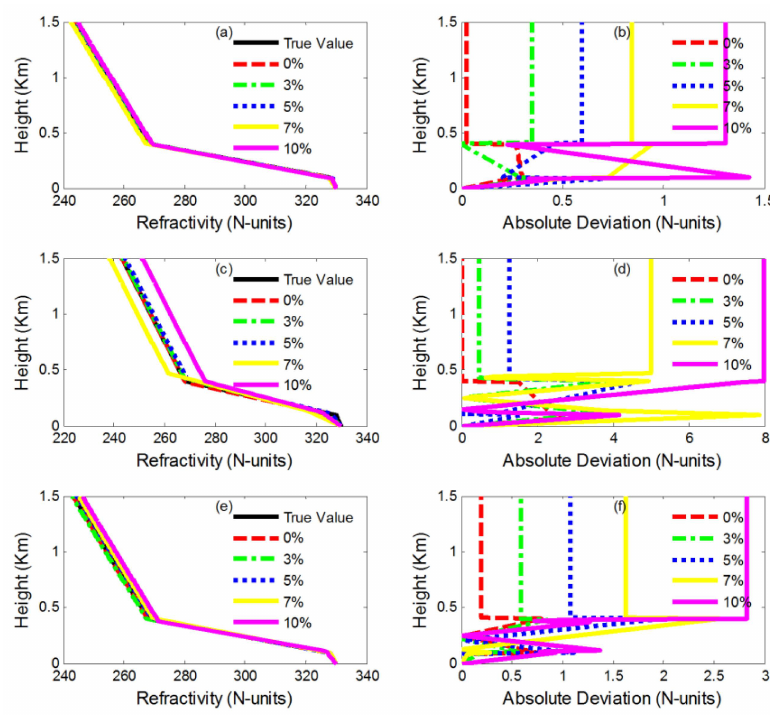
Figure 3. The retrievals with different Gaussian noise: ( a ) and ( b ) are the refractivity profile and corresponding refractivity deviation by NSGA-II; ( c ) and ( d ) are the refractivity profile and corresponding refractivity deviation by GA-Delay; ( e ) and ( f ) are the refractivity profile and corresponding refractivity deviation by